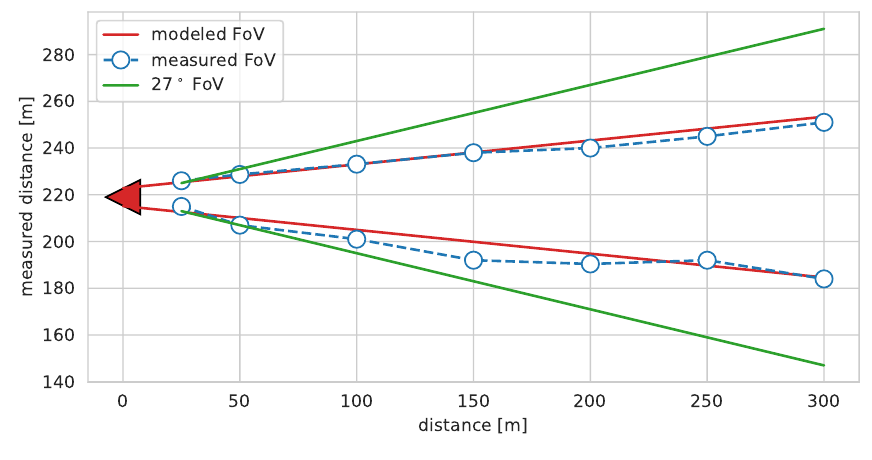
Figure 10. Measured FoV of